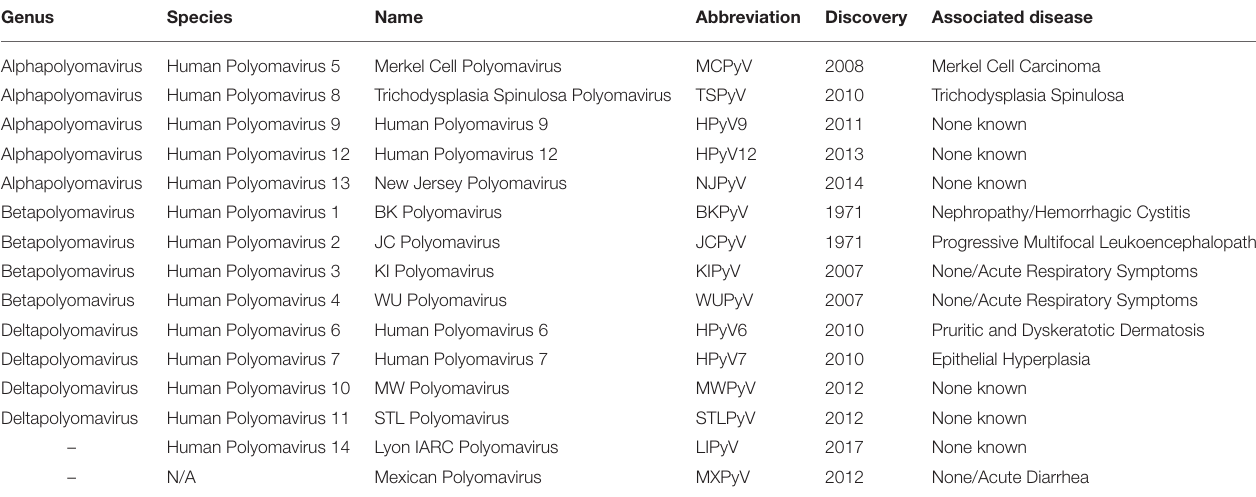
TABLE 1 | Human Polyomaviruses. Genus Species